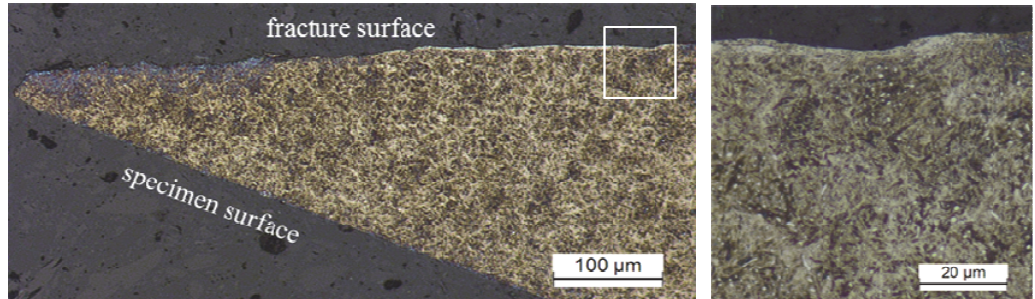
Figure 4: Metallographic section of an in-phase specimen tested in air. The smaller image on the right is a magnification of the marked